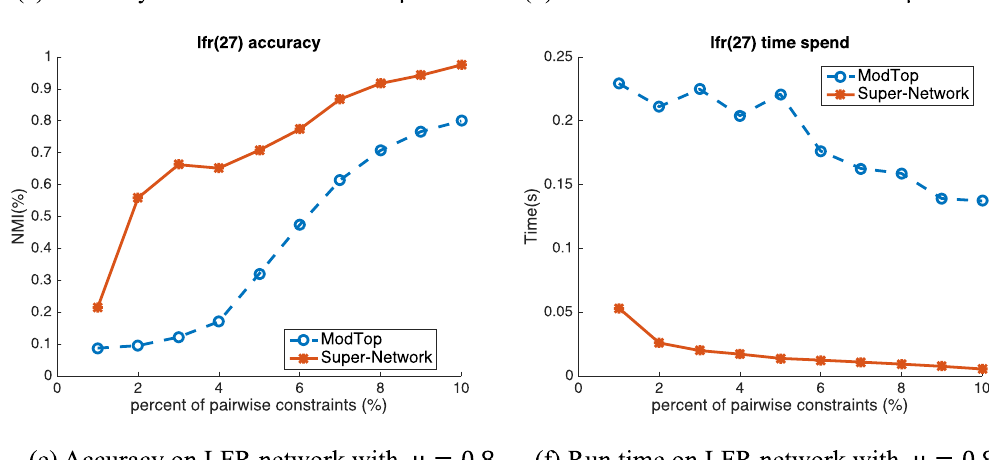
Figure 5. Accuracy (NMI) and run time (spent time in second) on LFR benchmark networks based on modularity maximization with spectral